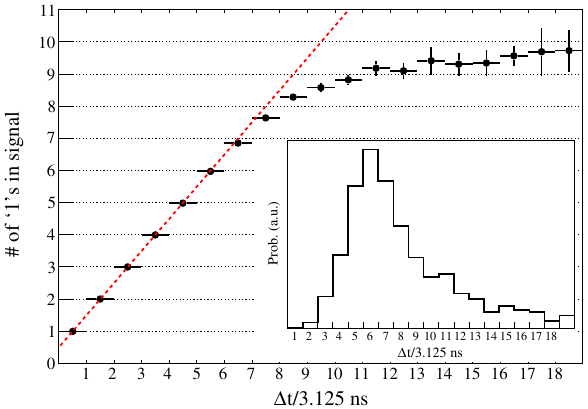
Fig. 4 Relationbetweenthenumberof‘1’sandthelengthofthedigital trace, Δ t. The red dashed line represents the identity function. The inset shows the distribution of Δ